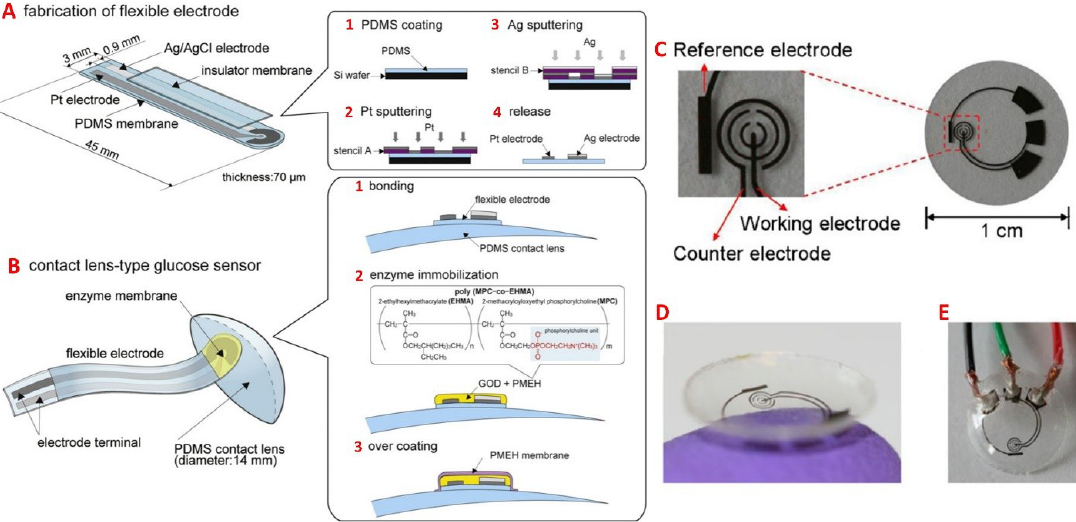
Figure 9. Fabrication process for a contact lens biosensor: ( A ) flexible electrodes, consisting of a 200 nm Pt working electrode and a 300 nm Ag/AgCl counter/reference electrode, were formed onto a 70‐ μm thick PDMS film. ( B ) The electrodes were then bonded onto a PDMS lens and coated with GOD as well as PMEH. Reproduced with permission [86]. Copyright 2011, Elsevier. ( C ) The circuitry used in the detection of glucose with reference, working, and counter electrodes. ( D ) Integration of the circuitry onto a contact lens and ( E ) the testing setup used. Adapted and reproduced with permission [39]. Copyright 2011, Elsevier.